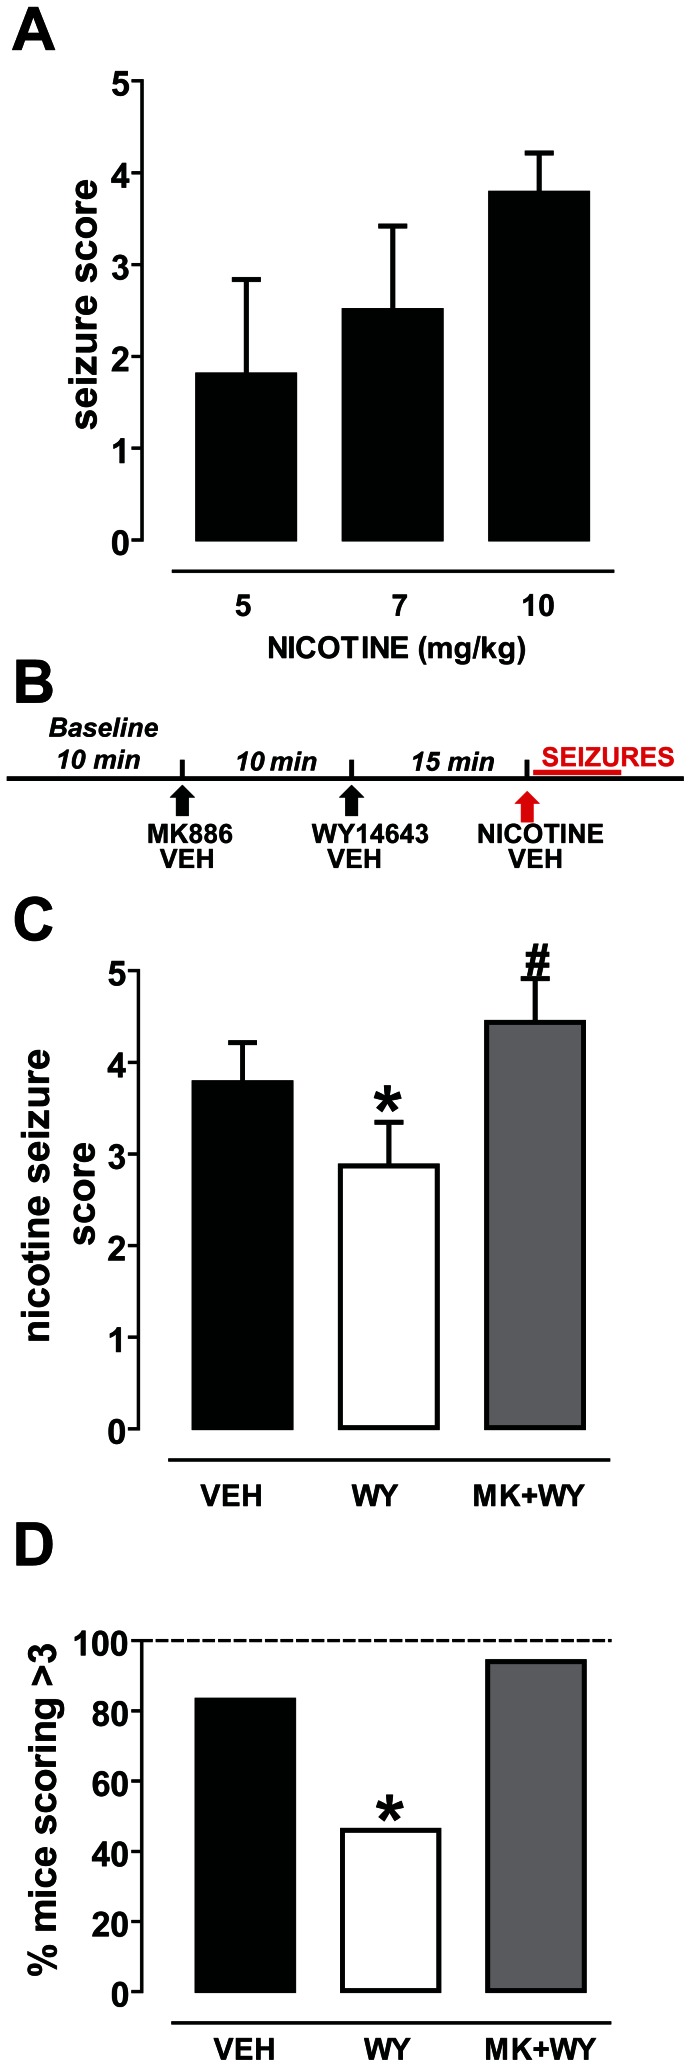
The PPARα agonist WY14643 reduces nicotine-induced seizures.(A) Graph displaying the dose-dependency of the severity of nicotine-induced seizures in C57BL/6 mice. Nicotine was administered subcutaneously at 5, 7 and 10 mg/kg (n = 4, n = 5, n = 18, respectively). (B) Schematic representation of the experimental protocol of experiments in (C) and (D). (C) The PPARα agonist WY14643 (WY, 80 mg/kg, i.p., n = 23) reduced the severity of nicotine-induced seizures (nicotine dose: 10 mg/kg, s.c) (*P<0.05 vs. vehicle, Dunn’s-test). This effect was abolished by the selective PPARα antagonist MK886 (MK, 3 mg/kg, i.p.). (n = 16, # P<0.001 vs. WY, Dunn’s-test). (D) This graph shows that the percentage of mice undergoing severe nicotine-induced seizures (indexed by scores >3) is significantly attenuated after WY14643 pretreatment (*P<0.05 vs. vehicle, Fisher’s test). MK886 reversed this effect (P>0.05 vs. vehicle, Fisher’s test). Data are expressed as mean±95% C.I.